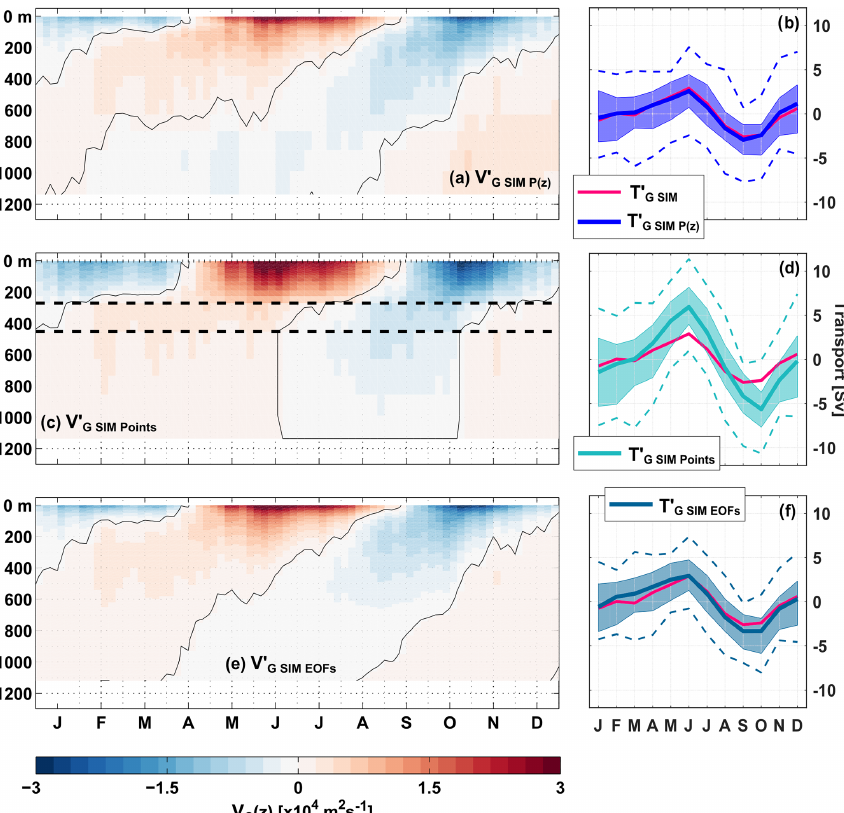
Figure 10. Mean seasonal cycles of the geostrophic transport per unit depth, V (cid:48) (a, c, e) and the upper-ocean geostrophic transport T (cid:48) GSIM GSIM (a) and T (cid:48) (pink curves; b, d, f ) from INALT01. V (cid:48) (blue curve; b ) were calculated using the full vertical profiles of BP. GSIM P(z) GSIM P(z) V (cid:48) (c) and T (cid:48) (cyan curve; d ) were reconstructed by piecewise linear interpolation of V (cid:48) between the four supporting GSIMPoints GSIMPoints G (e) and T (cid:48) points at 0, 300, 500 and 1130m depth (dashed black lines in panel c mark the depths of the BPRs); V (cid:48) (petrol GSIMEOFs GSIMEOFs curve; f ) by using the dominant vertical structure functions from INALT01. In panels (a, c, e) , red (blue) colours show northward (southward)